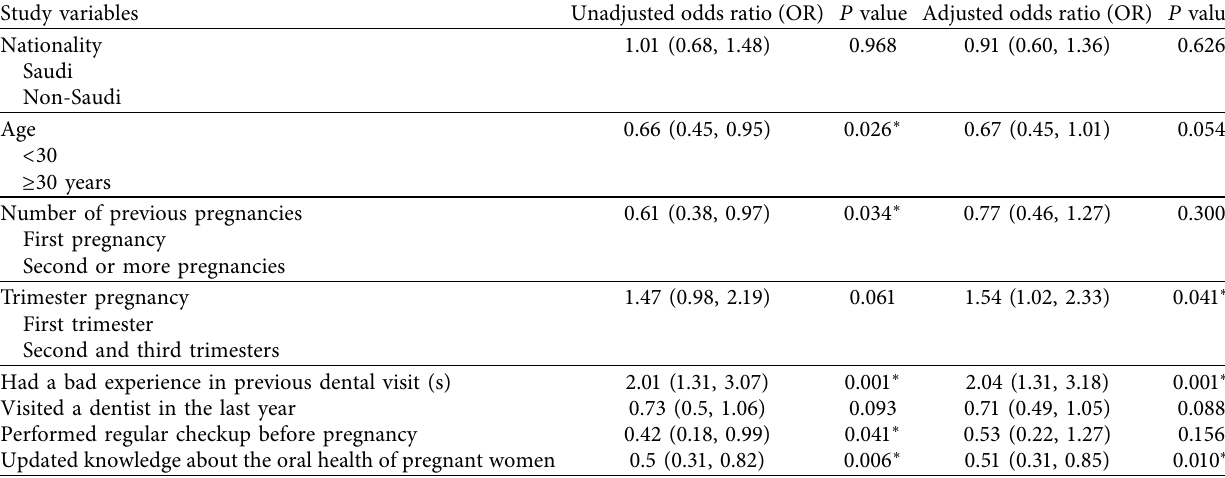
Table 3: Association between various factors and dental phobia in pregnant women. Study